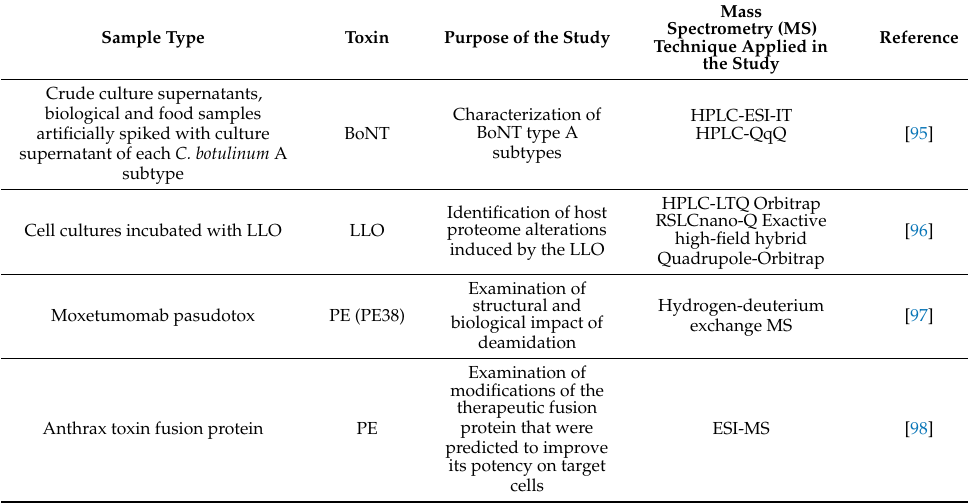
Table 4. The role of proteomics in the study of bacterial toxins with anticancer